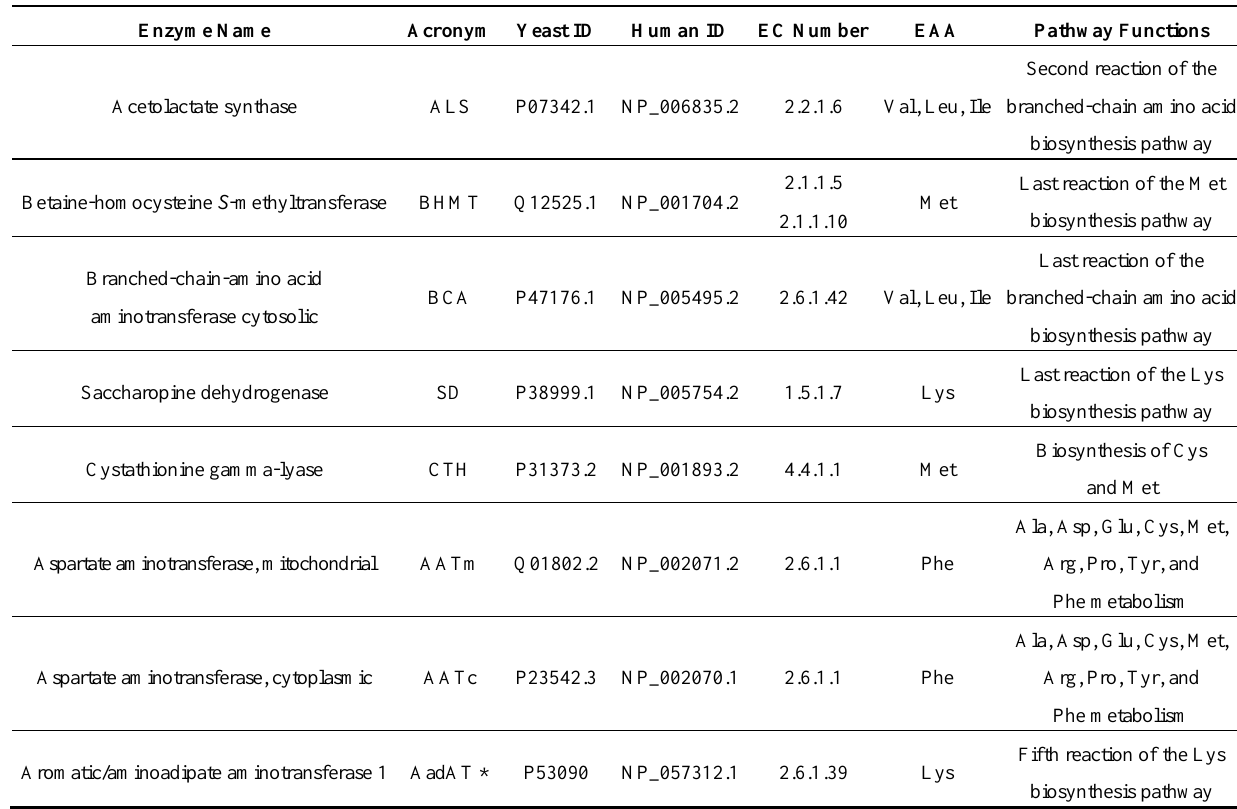
Table 1. Essential amino acids (EAA) biosynthesis enzymes with homologs in